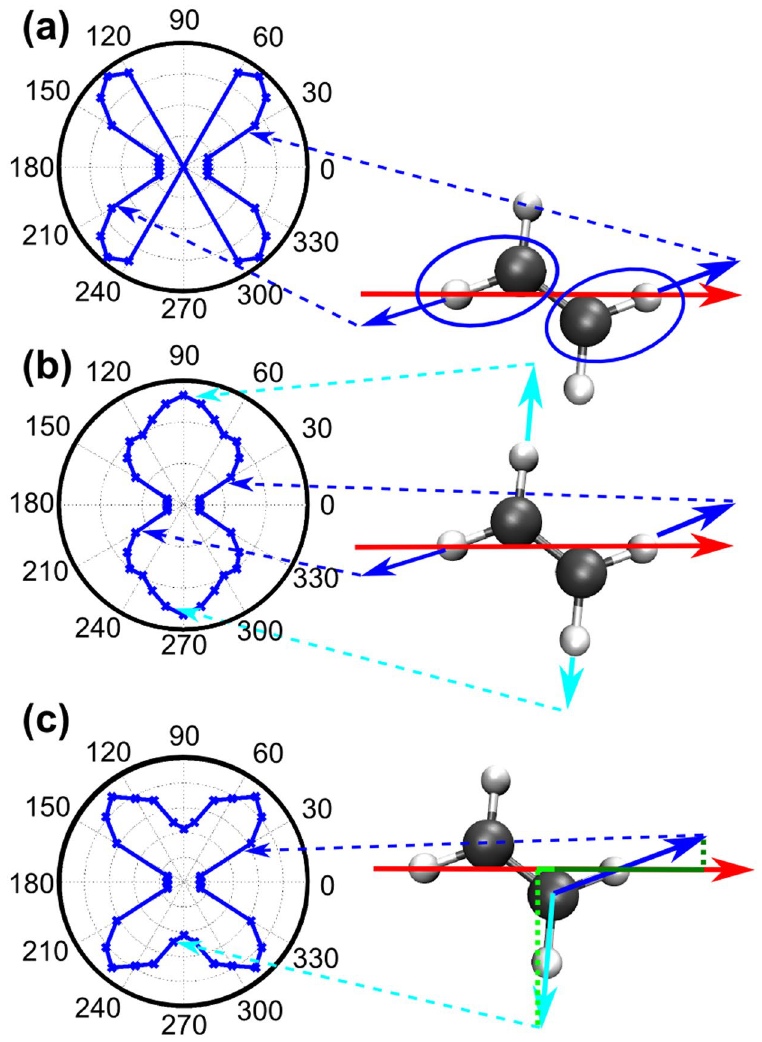
Figure 5. Schemes for calculating the photofragment angular distributions in C 2 D 4 (right) and corresponding results (polar plots, left). The red arrow indicates the direction of the dipole field. The dashed arrows relate the orientation of the molecule to the dipole vector with the angle between the field and the dissociation direction plotted in the polar diagram. ( a ) Contributions from the hole localized at “nearby” C-H bonds only. The blue vectors indicate the dissociation direction of these H-atoms. ( b ) The hole delocalizes quickly, allowing all C-H bonds to dissociate with equal probability. The cyan vectors indicate the dissociation direction of the more remote H-atoms ( c ) Contributions to dissociative ionization yield are weighted partially by their projection to the dipole vector which is indicated by the dark and light green line, respectively (see Eq. (4)). The individual projections are indicated as dotted